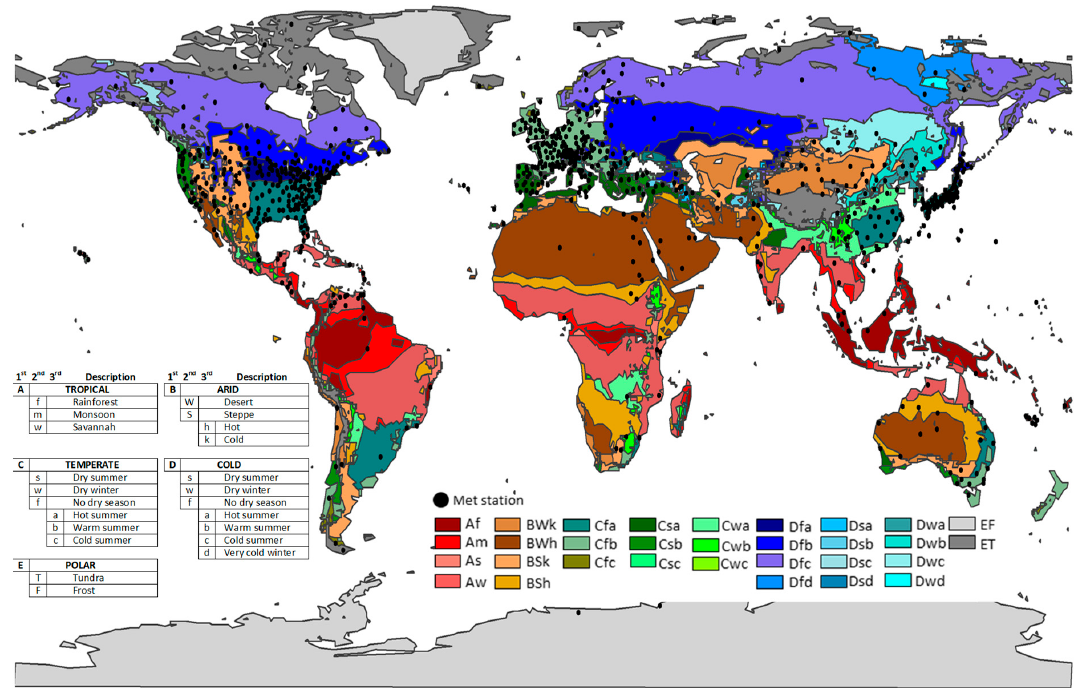
Figure 4. Location of the meteorological stations in the Köppen–Geiger climate classification areas. Source: [72] and self-elaboration.